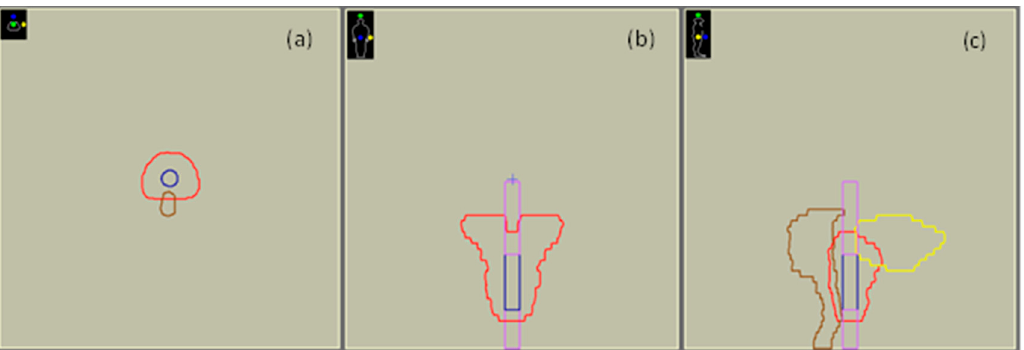
Figure 2. Screenshots from Monaco ® 5.11.02 TPS used for treatment planning and dose calculations presenting the computational model at the central axial ( a ) coronal ( b ) and sagittal ( c ) slice of the blood tube. Legend: red contour: PTV, brown contour: rectum, yellow contour: bladder, dark blue contour: blood tube, magenta contour: air-filled inserts .